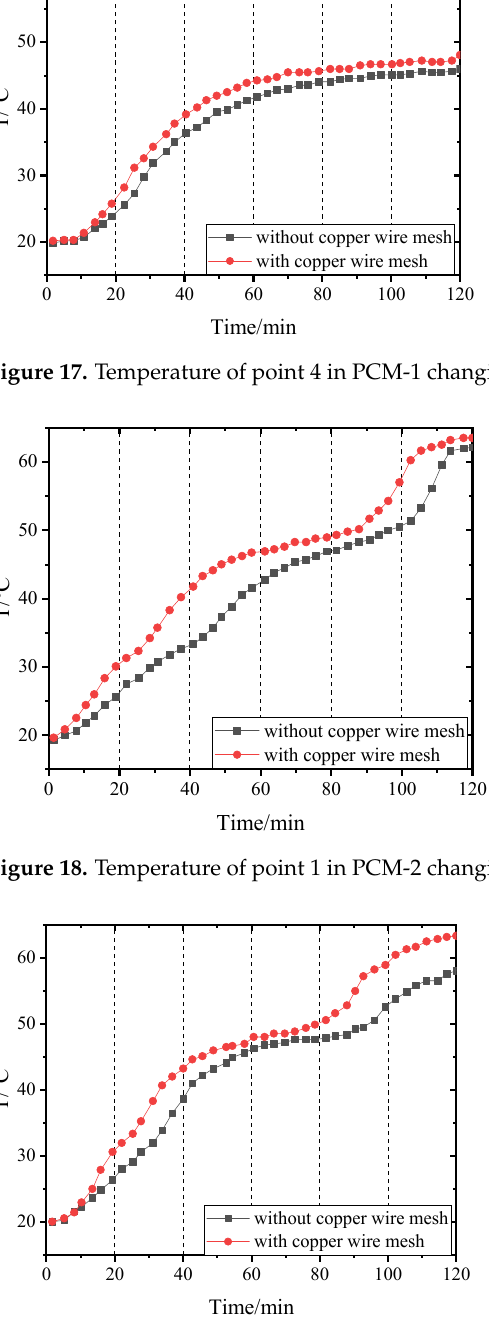
Figure 17. Temperature of point 4 in PCM-1 changing with time.